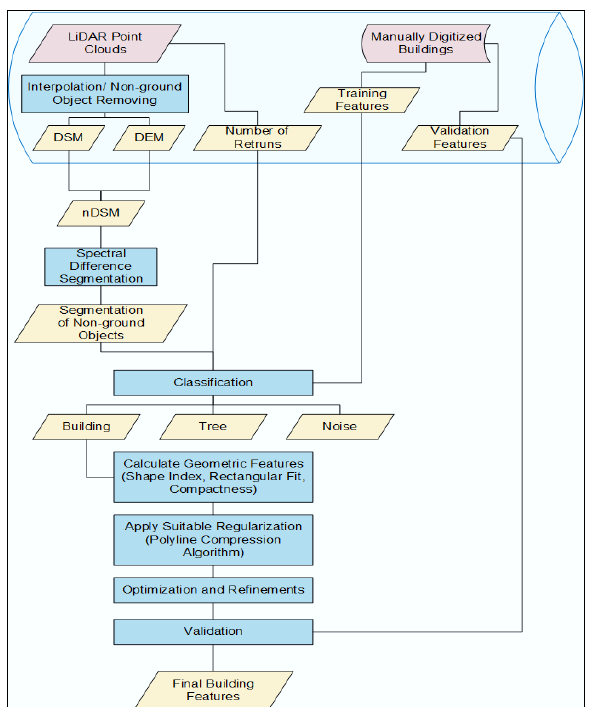
Figure 2. The overall